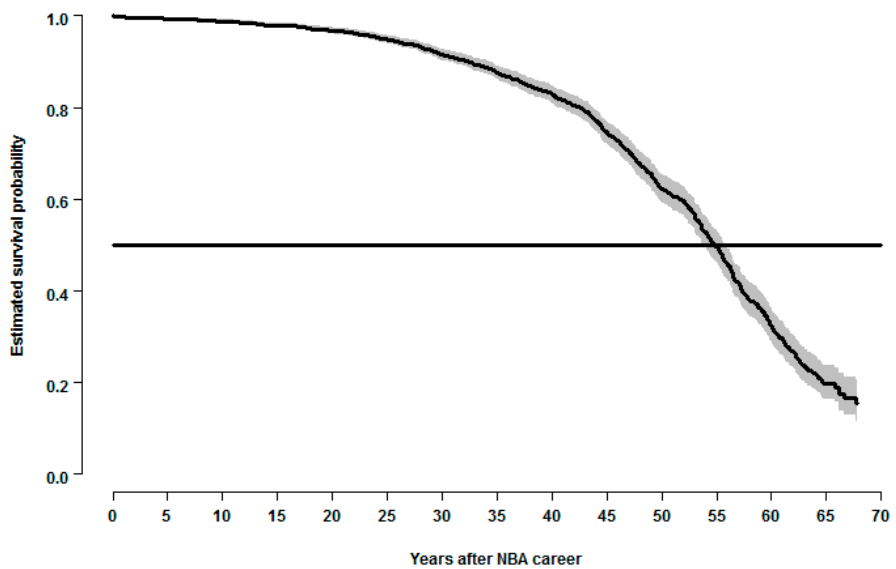
Figure 1. Estimated survival probabilities of former NBA players after their NBA career. The shaded area represents the 95% confidence bands, and the horizontal line represents survival probability of 0.5.